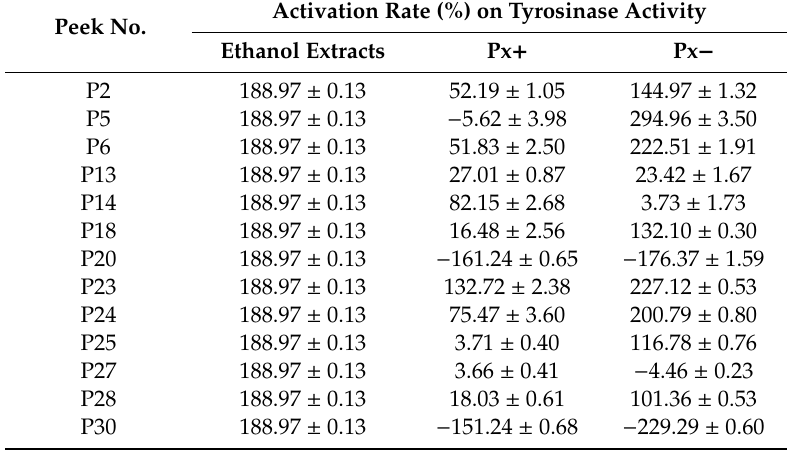
Table 2. Activation e ff ects of the knocked-out components of water extract of P. corylifolia and negative samples on